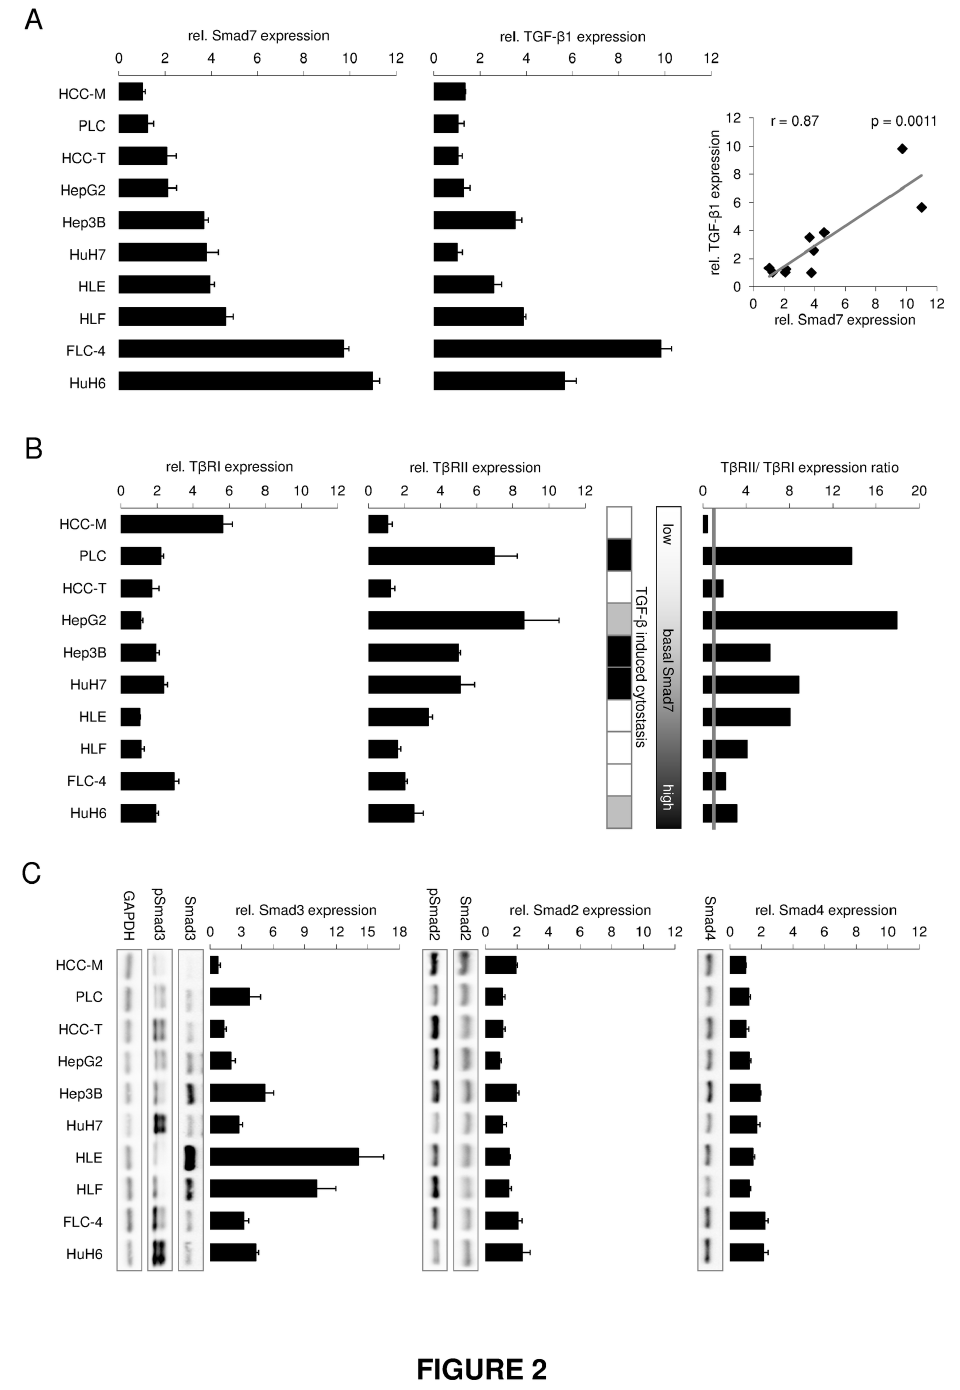
Figure 2. Expression levels of TGF-β/Smad signaling components in HCC cell lines. Relative TGF-β1 and Smad7 (A), TGF-β receptor I (TβRI) and II (TβRII) (B) and Smad2, Smad3, and Smad4 (C) expression levels were detected using real time PCR. Expression of 18s rRNA was used as reference and results were analyzed with the ΔΔCt method. A strong correlation of Smad7 and TGF-β1 expression was identified by calculating the Pearson coefficient (r = 0.87; p = 0.0011) (A). Further, TβRII expression (filled bars) was generally increased compared to the expression of TβRI (grey line) in the same cell line (B, right). Additionally, total and phosphorylated Smad2 and Smad3 as well as basal Smad4 protein levels were evaluated by Western Blot using GAPDH as loading control (C). doi: 10.1371/journal.pone.0072252.g002 PLOS ONE |